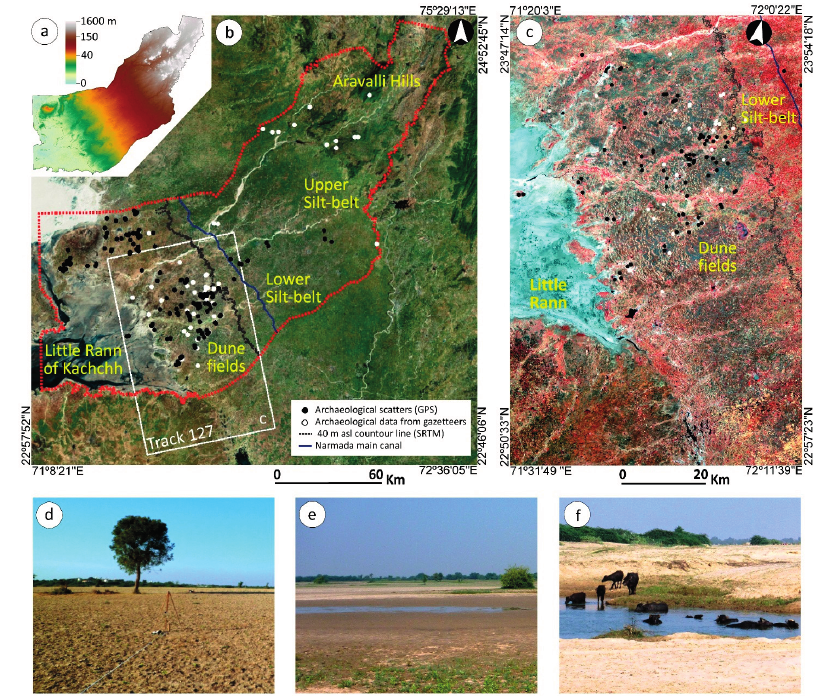
Figure 2. ( a ) Regional slope (SRTM 90 v4.1, http://srtm.csi.cgiar.org); ( b ) Archaeological scatters within NoGAP research area (red dotted line) and extent of ENVISAT ASAR scenes in ascending mode, Track 127, Swath I6 (base map: ESRI World Imagery); ( c ) Extent of Track 127 displayed as LANDSAT 8 OLI false colour composite (5-4-3, 3 April 2014); ( d ) Fossilized dune surface (Kalrio Timbo archaeological site) during post-monsoon (November 2011; ( e ) Interdune black cotton soils waterlogged during post-monsoon (November 2010); ( f ) West Banas riverbed (November